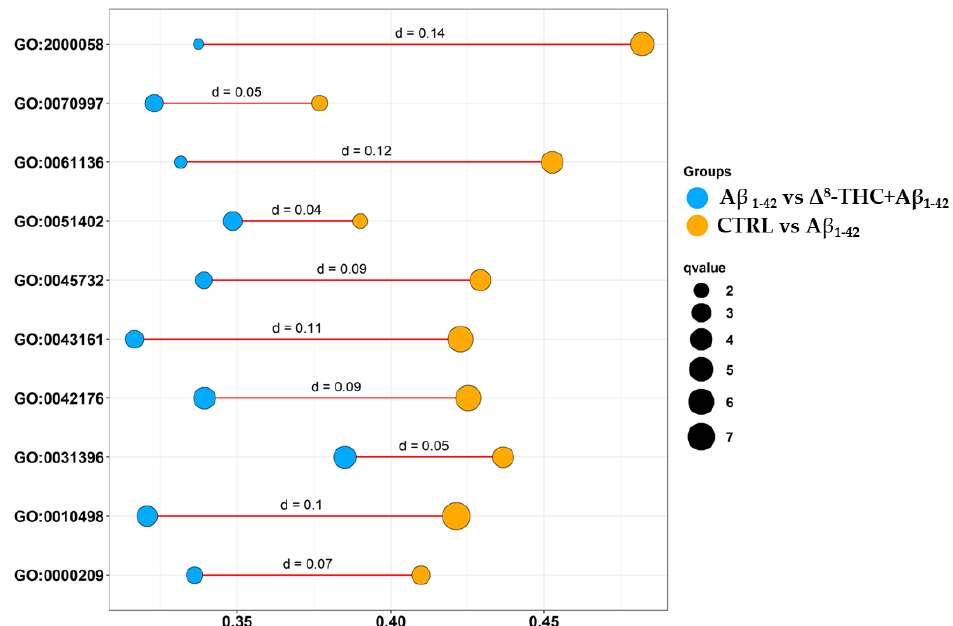
Figure 3. Bubbleplot of biological process terms enriched in gene ontology between CTRL vs. Aβ 1-42 and Aβ 1-42 vs. Δ 8 -THC + Aβ 1-42 groups. For each ontology reported on the y axis, a bubble for the CTRL vs. Aβ 1-42 (orange) and one for the Aβ 1-42 vs. Δ 8 -THC + Aβ 1-42 (light blue) groups were plotted. The position of the bubble in the x axis shows the number of DEGs in the ontology (the more on the right, the higher the number of DEGs). The number of DEGs was normalized over the number of genes included in the ontology term itself so that the terms were comparable to each other. The size of the bubble is a score given by −log(q-value). Table 1. Common DEGs, altered in both CTRL vs. A β 1-42 and A β 1-42 vs. ∆ 8 -THC + A β 1-42 , related to “Alzheimer’s disease” (hsa05010) and “protein processing in endoplasmic reticulum” (hsa04141)